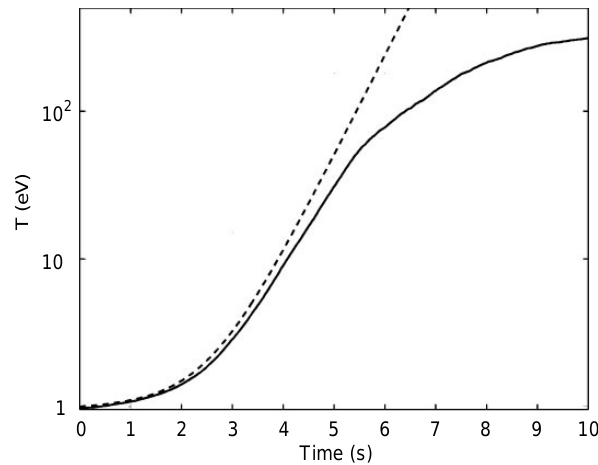
Fig. 7. The increase of the perpendicular temperature at v presence of a fan instability. The solid line shows the simulation result, and the dashed line the approximation in Eq. (20)